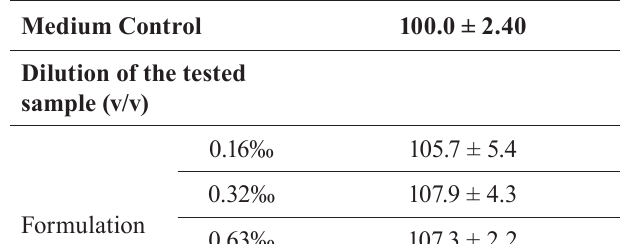
formulations ETF